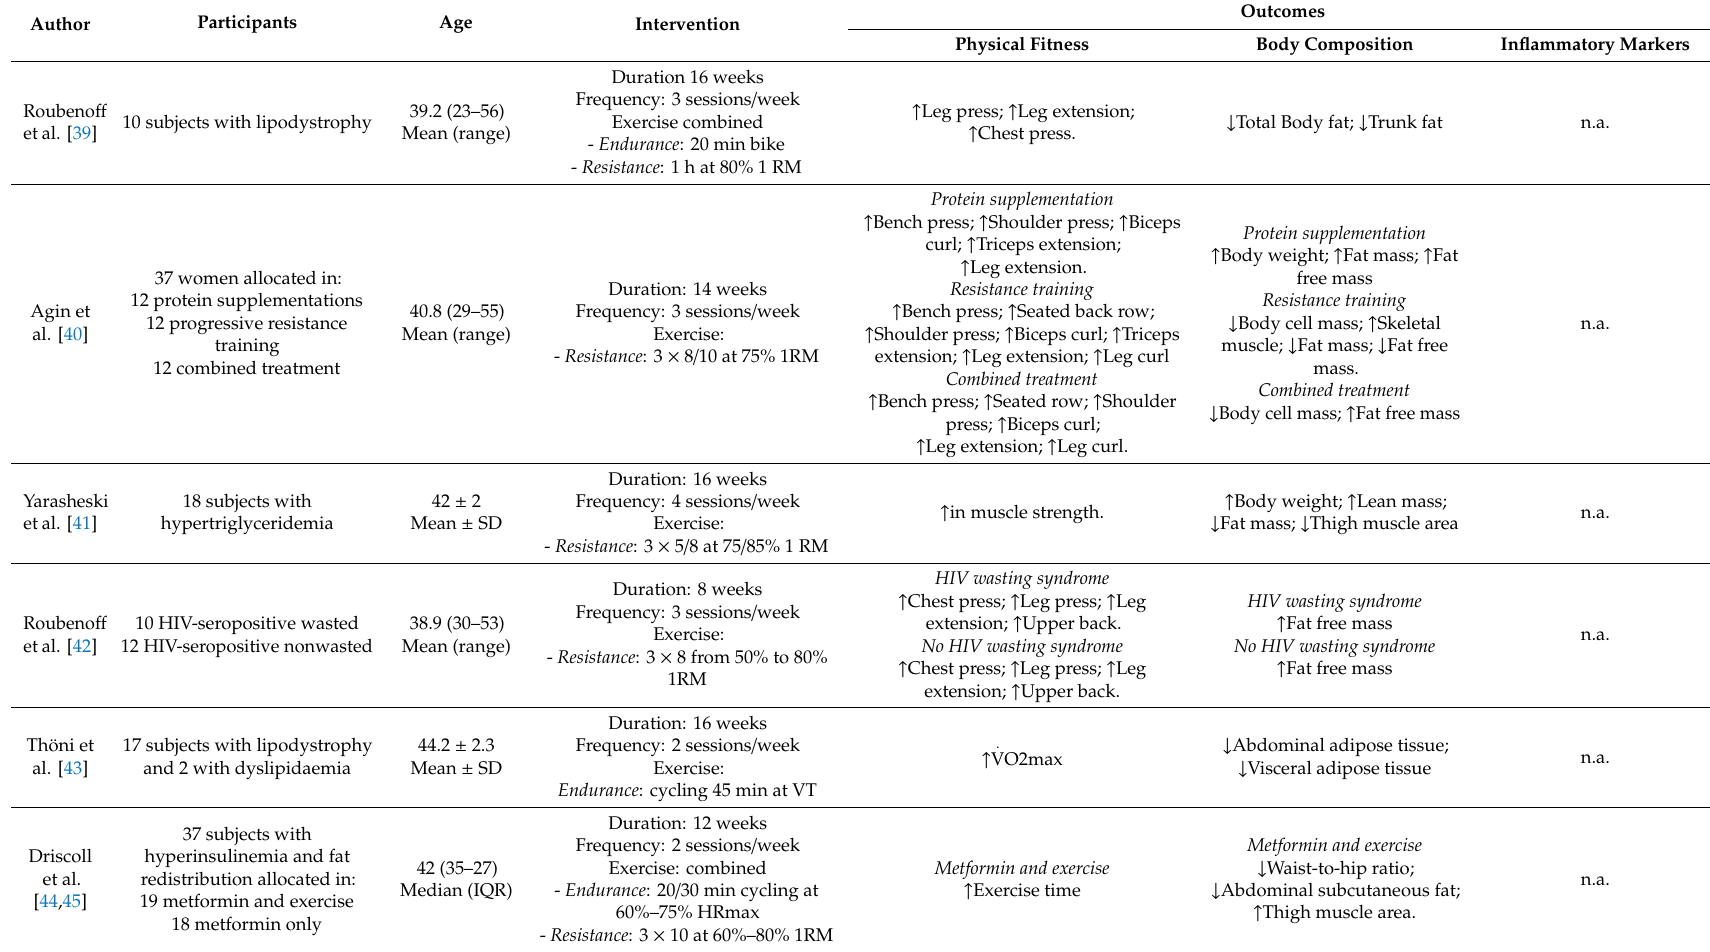
Table 1. Longitudinal interventional studies that assessed the e ff ect of physical activity on physical fitness, body composition and inflammatory markers in cART-treated people living with